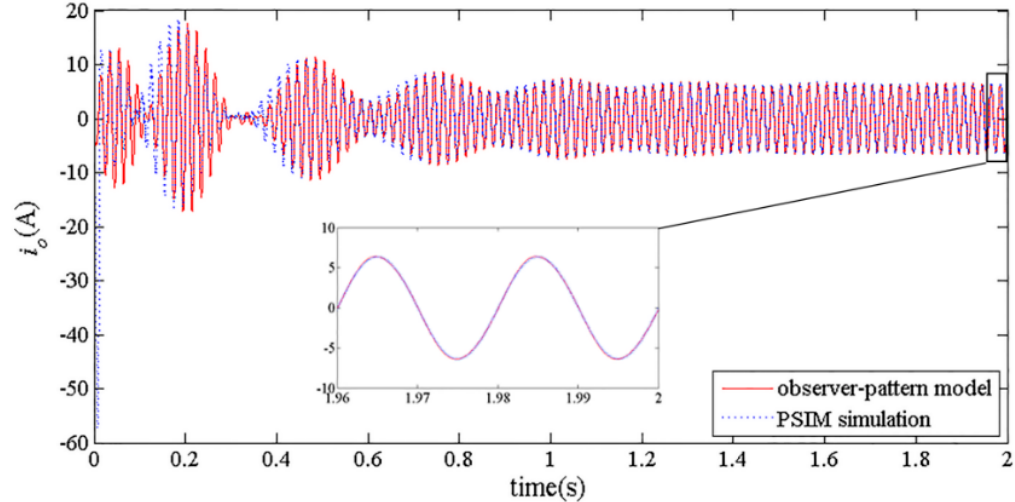
Figure 2. DC bus voltage waveform.